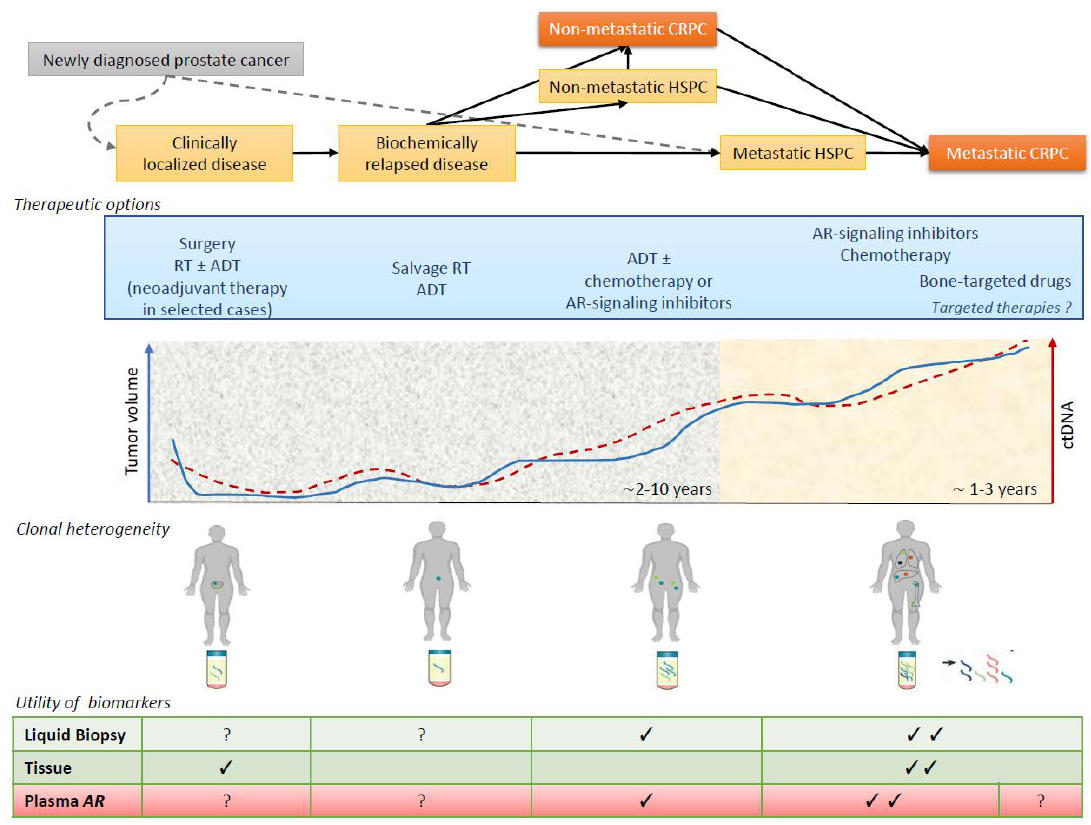
Figure 1. The role of biomarker tools and plasma AR status in different clinical states of prostate cancer. A clinical states framework for clinical practice, clinical research, and biomarker tools in prostate cancer with a graphical representation of tumor burden, plasma DNA levels, clonal heterogeneity, and utility of plasma AR status over time and in response to therapy. Abbreviations: ADT, androgen deprivation therapy; AR, androgen receptor; CRPC, castration-resistant prostate cancer; ctDNA, circulating tumor DNA; HSPC, hormone-sensitive prostate cancer; RT, radiotherapy.